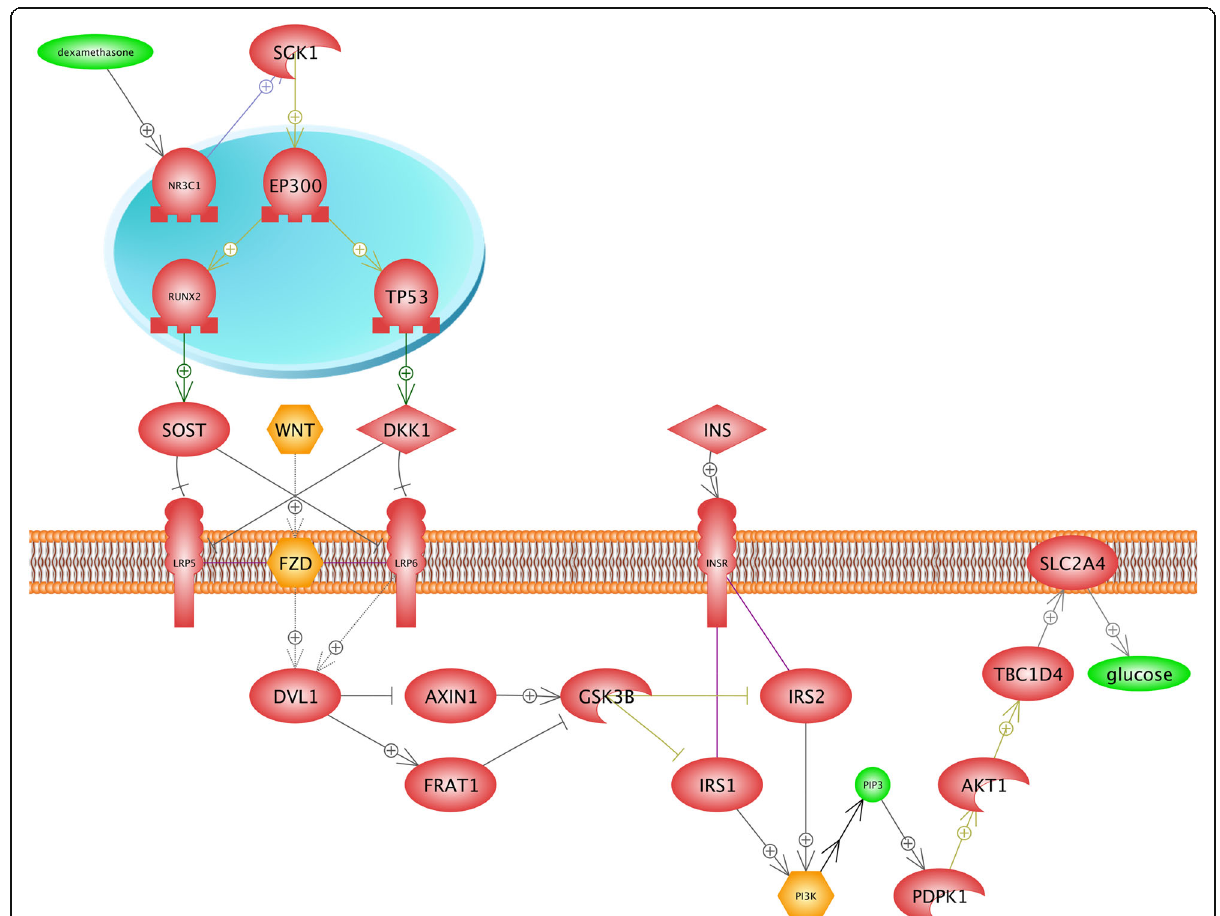
Fig. 5 The role of dexamethasone in the process of inducing diabetes in hypoxia condition. This figure illustrates that the NR3C1 gene activates SGK1 (Serine/threonine-protein kinase) and other TFs block two receptors ( LRP6 and LRP5 ) in the cell membrane. In fact, SGK1 gene is well known as the regulator for many biological pathways such as TFs, receptors, and transporters. Thus, WNT-FZD (Wingless/Int1-Frizzled) and LRP6 activate protein kinase GSK38 . We found that it has a positive effect on the SLC2A4 gene, indirectly. It is proved that the SLC2A4 gene encodes the glucose transporters family (GLUTs) in diabetes, which is considered as an insulin-sensitive transporter. GLUTs contribute in glucose hemostasis and diabetes